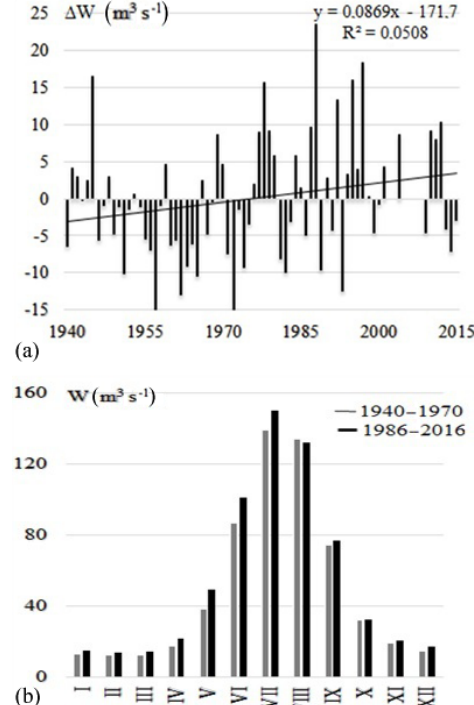
Figure 14. Deviation of annual discharge of the Vanch River from the long-term average (1940–2016) and trend (a) , and hydrological regime for the periods 1940–1970 and 1986–2016 (b) .